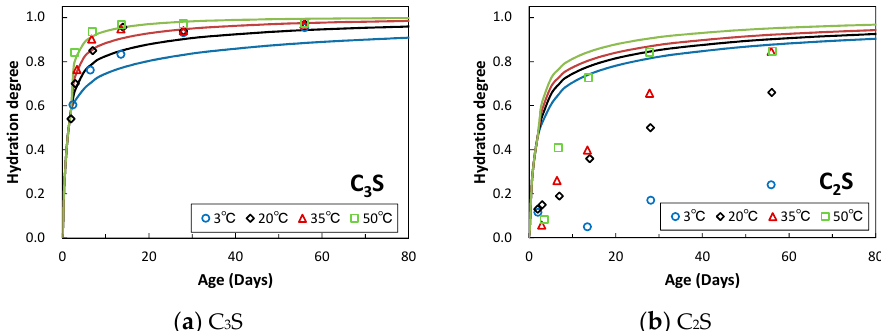
Figure 6. Comparison of degree of hydration among different curing temperatures based on the original model (OPC, W/C = 50%) [18].